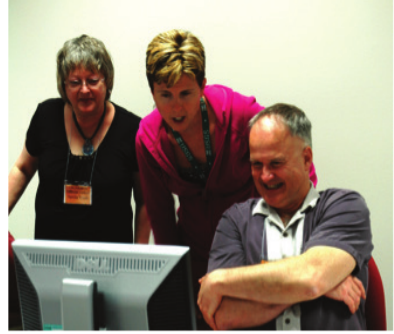
Figure 6. Debbie Stevens (IA), Rachel Headley (SD) and Hector Douglas (AK) in the computer